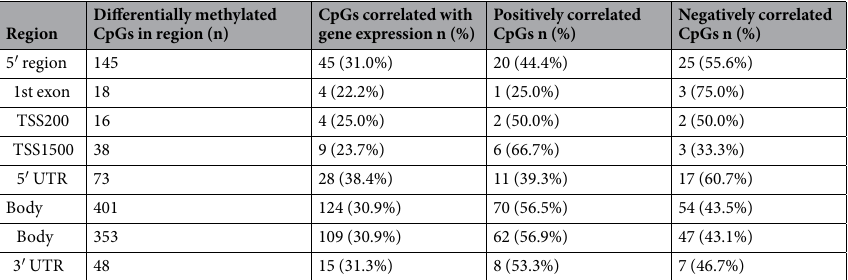
Table 1. Correlations between CpG site methylation and gene expression.